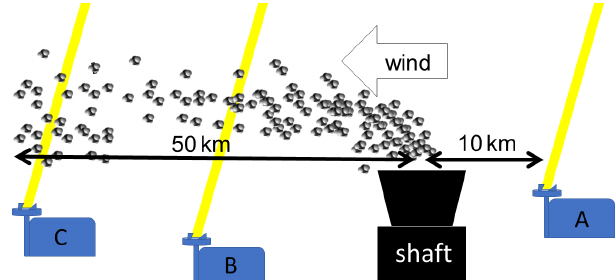
Figure 5. Lagrangian time lag sketch. Instrument A measures back- ground methane (upwind). The methane enhancements induced by the emissions of the shaft are calculated by subtracting the back- ground (upwind) measurements from the downwind observations of instruments B and C. Depending on wind speed, the air mass mea- sured by instrument A will be at instrument B and C after different travel